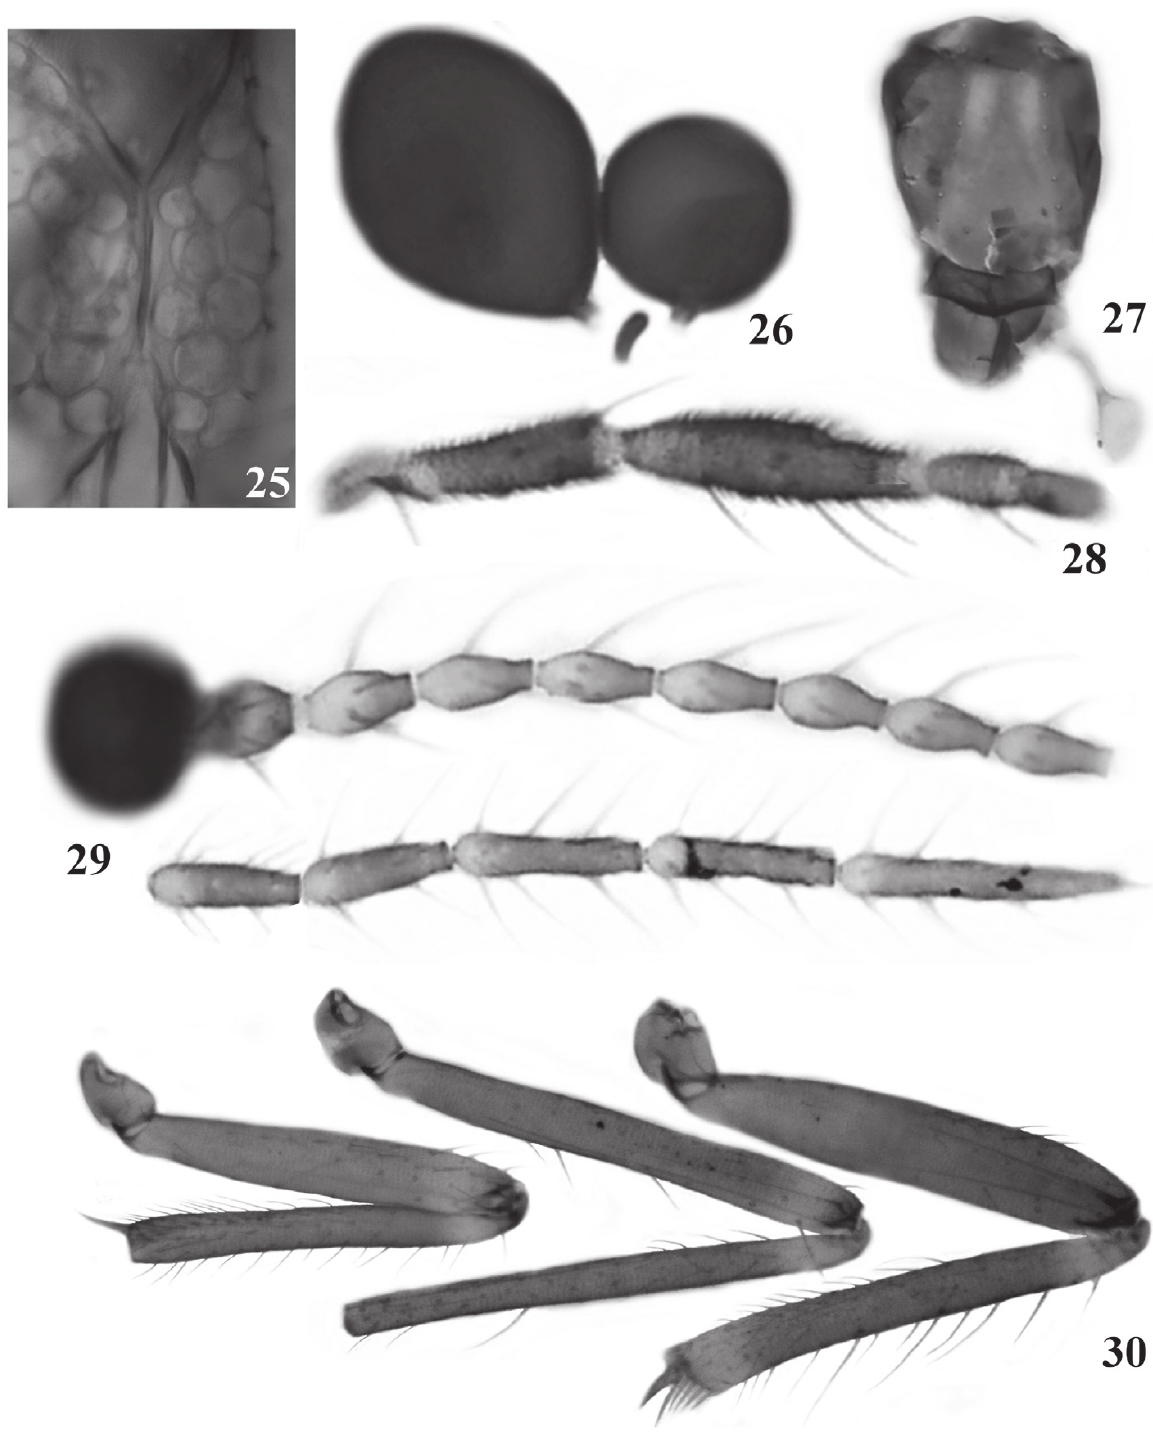
Figures 25-30 - Culicoides castelloni sp.nov, female holotype. 25. Eyes separation, anterior view. 26. Spermathecae. 27. Scutum. 28. Palpus. 29. Antenna. 30. Legs (left to right) fore, mid and